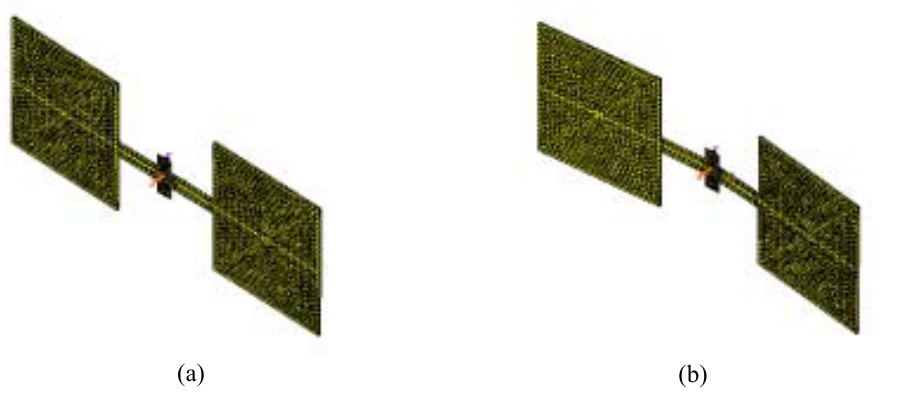
Figure 5. First (a) and second (b) mode shapes of the sensitive